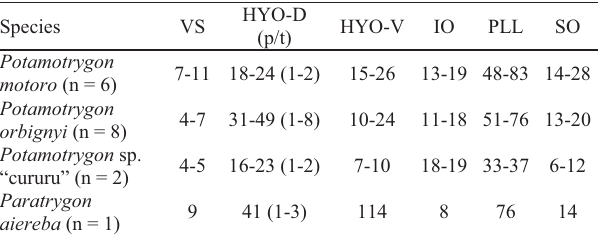
Table 1. Numbers (min - max) of vesicles of Savi (VS), pores in each pored canals, and pores per tubule (p/t) on the dorsal and ventral body surfaces. IO) infraorbital, HYO-D) dorsal hyomandibular, HYO-V) ventral hyomandibular, PLL) posterior lateral line, and SO)